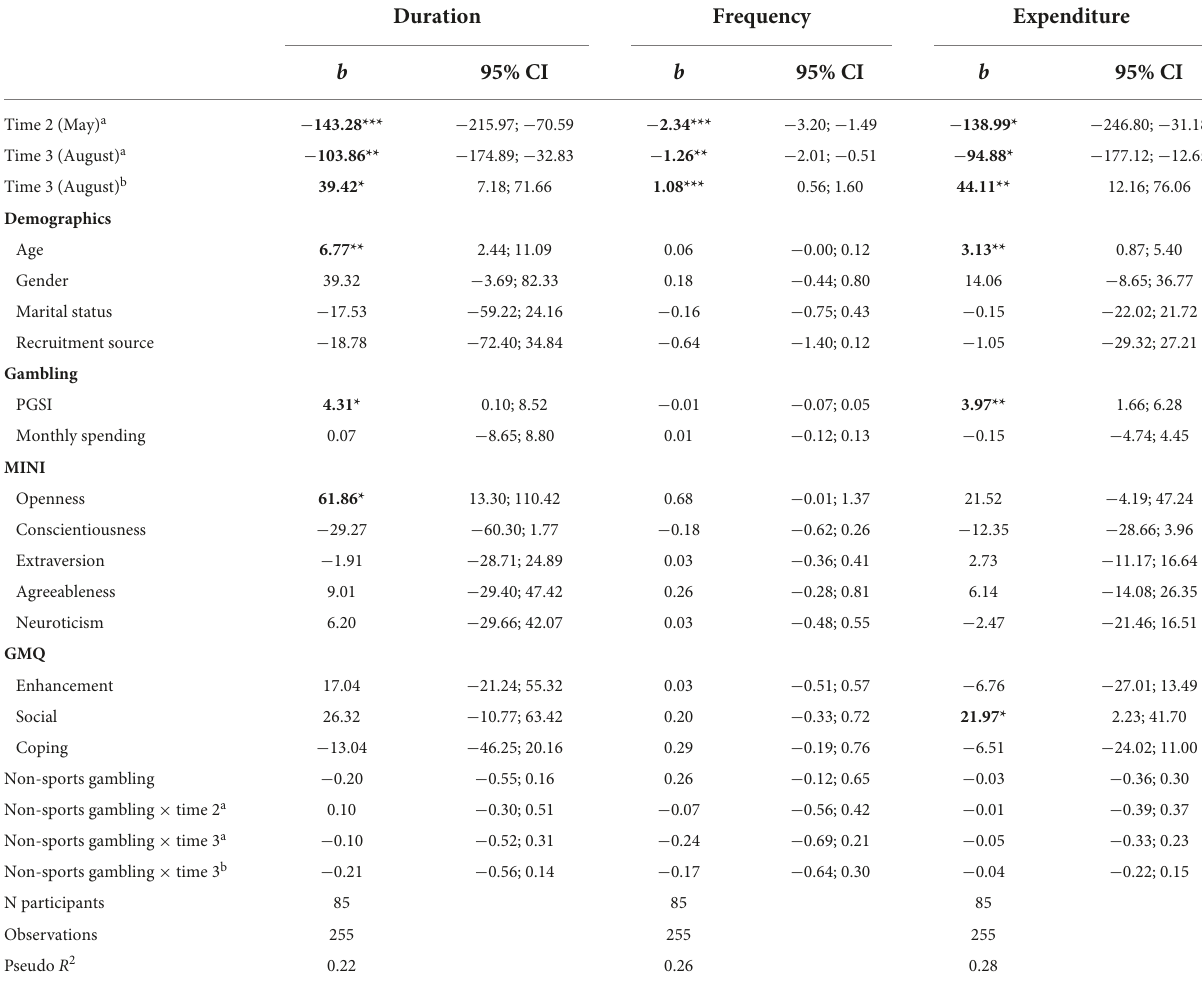
TABLE 3 Linear mixed-model results for sports gambling